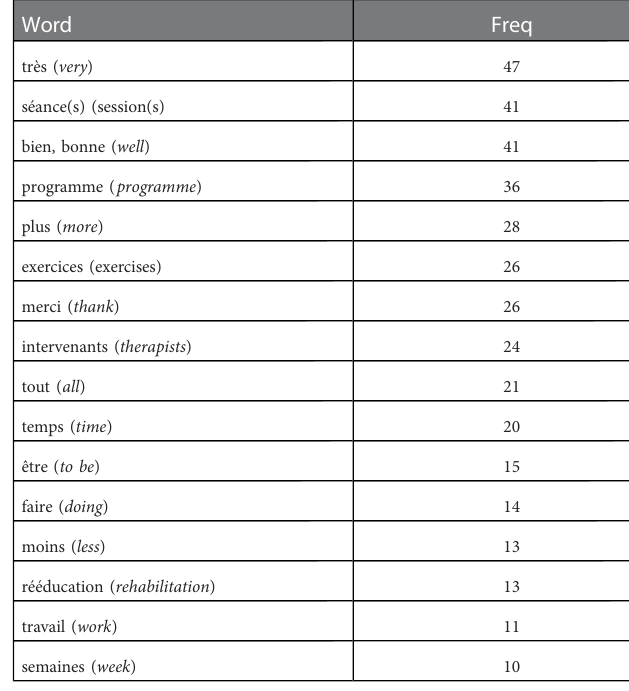
TABLE 5 Analysis of the occurrence of vocabulary used in the open-ended text, the 17 most frequent words Physiotherapists and occupational therapists were grouped together under the term therapist.